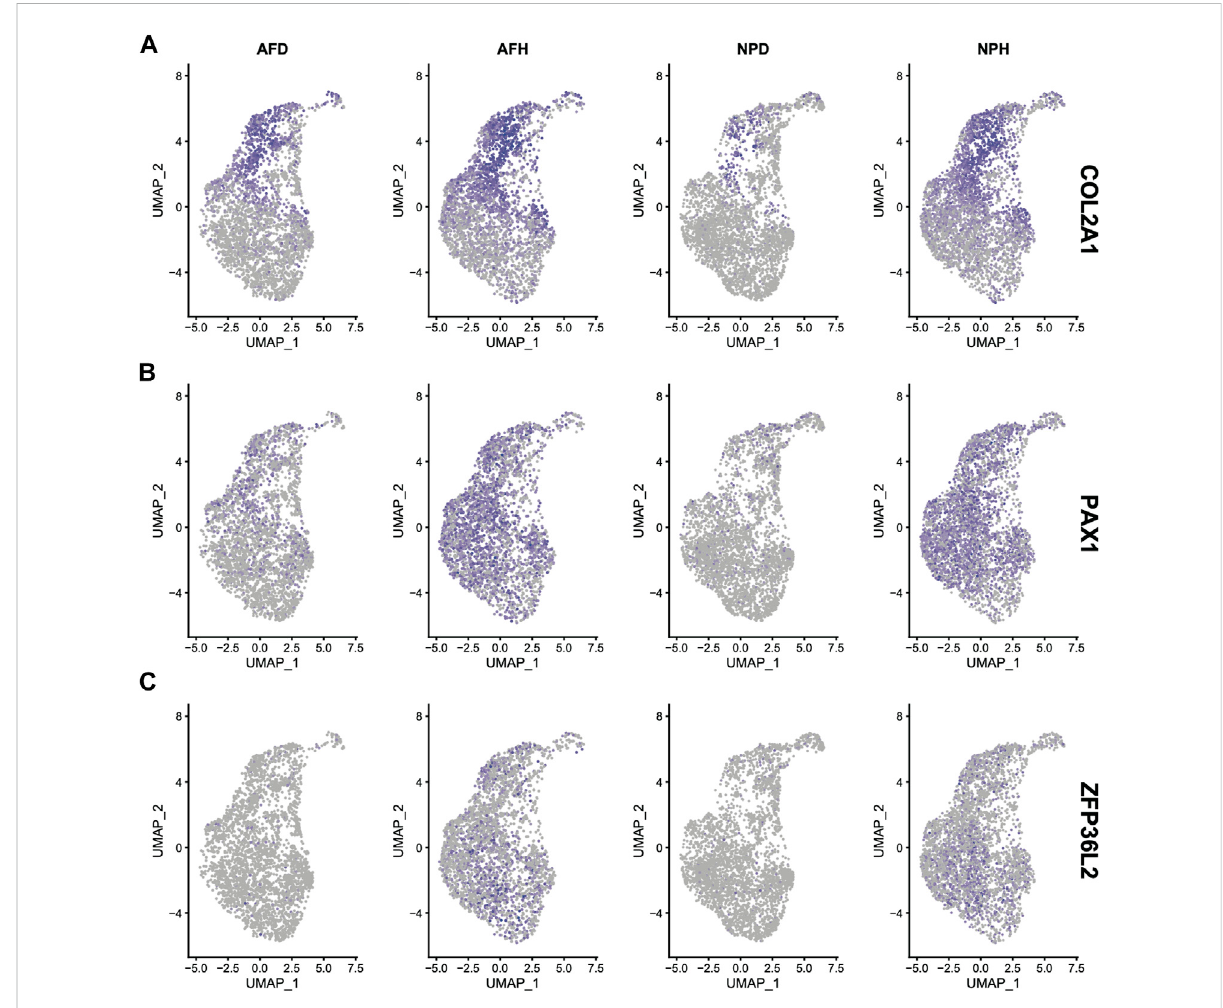
FIGURE 7 Expression of COL2A1 (A) , PAX1 (B) , and ZFP36L2 (C) in the four single-cell samples.